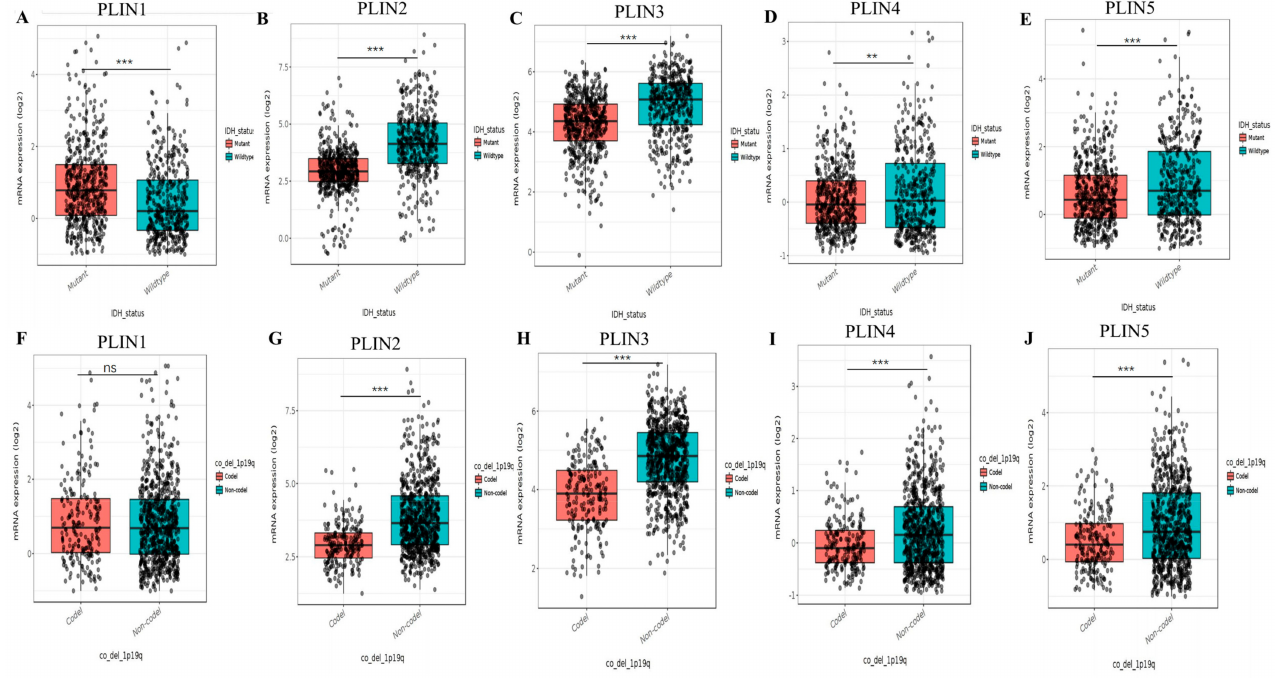
Figure 4. Correlation analysis of PLINs with molecular pathological features of glioma. ( A – E ) Differential mRNA expression levels of PLIN1 − 5 in glioma IDH mutant and wild type (** p < 0.01; *** p < 0.001, ns: no significance). ( F – J ) Differential mRNA expression levels of PLIN1 − 5 in glioma 1p/19q coding and non-coding (** p < 0.01; *** p < 0.001, ns: no significance).